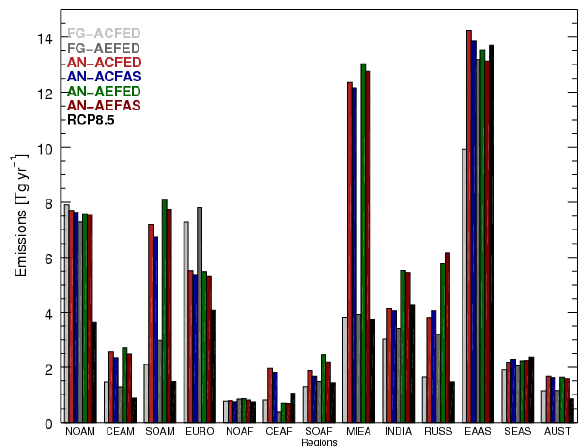
Fig. 5. Same as Fig. 3 but for annual emissions of (a) BC and (c) POM from fossil fuel (FF) combustion in the thirteen regions illustrated in Fig. 1a and annual emissions of (b) BC and (d) POM from biomass burning (BB) in the fifteen regions illustrated in Fig. 1b.